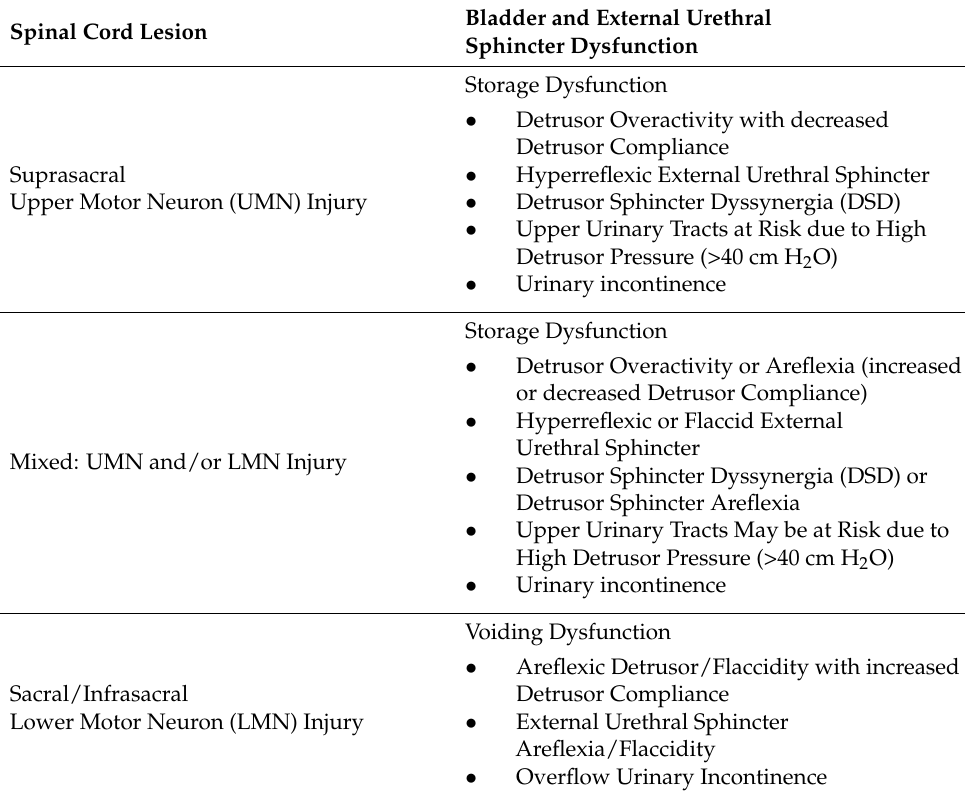
Table 2. Spinal cord level of injury and associated